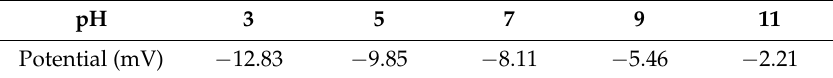
Figure 5. Effects of initial solution pH ( a ), initial solution concentration ( b ), coexisting ions ( c ) on MB, RhB and TCH photodegradation performance by 0.10CdS@TiO 2 . Table 1. The Zeta potentials of 0.10CdS@TiO 2 composite under different solution